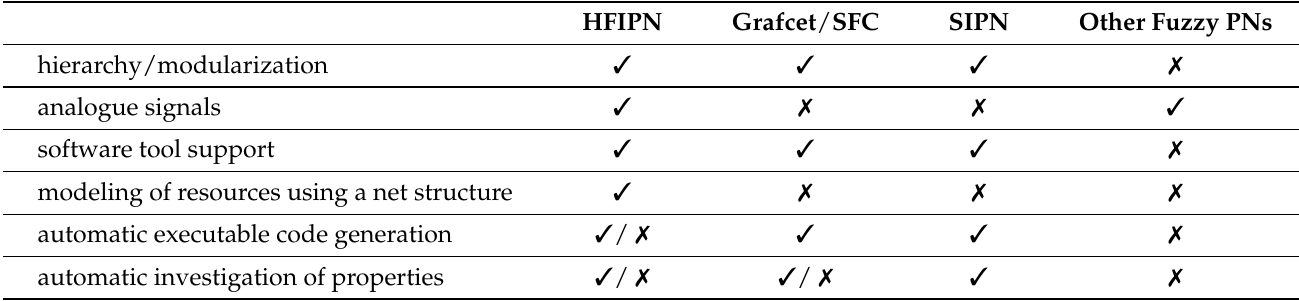
Table 1. Comparison of HFIPN to similar